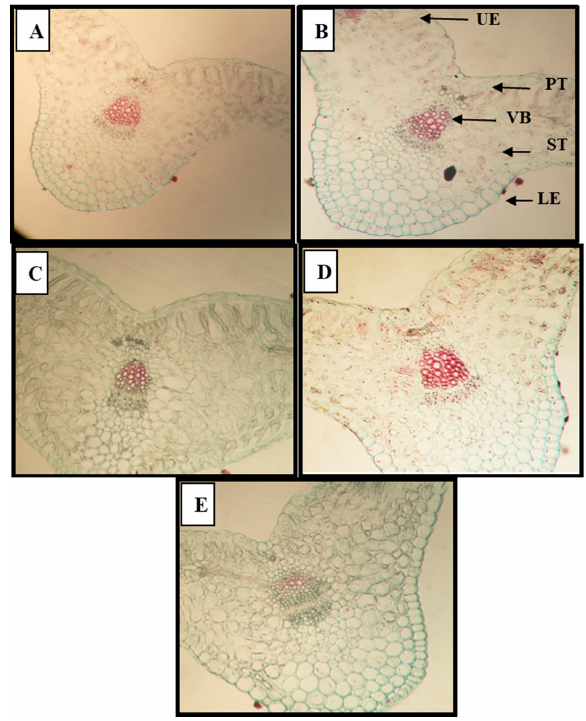
Figure 2. Effect of spent mushroom substrate extract (SMSE) , and mushroom culture filtrate (MCF) and Roundup on anatomical characters of infested faba bean leaves (leaflet) with broomrape in the tolerant cultivar (Misr 3) during the second season (2018/2019). A. Control of tolerant cultivar (MC) B . Spraying + soil amendment with 10% solution of SMSE (M2). C . Spraying + soil amendment with 10% MCF (M5). D . Soil amendment with 10% MCF (M6). E . Spraying with Roundup (144 cm 3 ha − 1 ) (M7). UE—Upper epidermis. PT—Palisade tissue. ST—Spongy tissue. VB—Vascular bundles. LE—Lower epidermis.